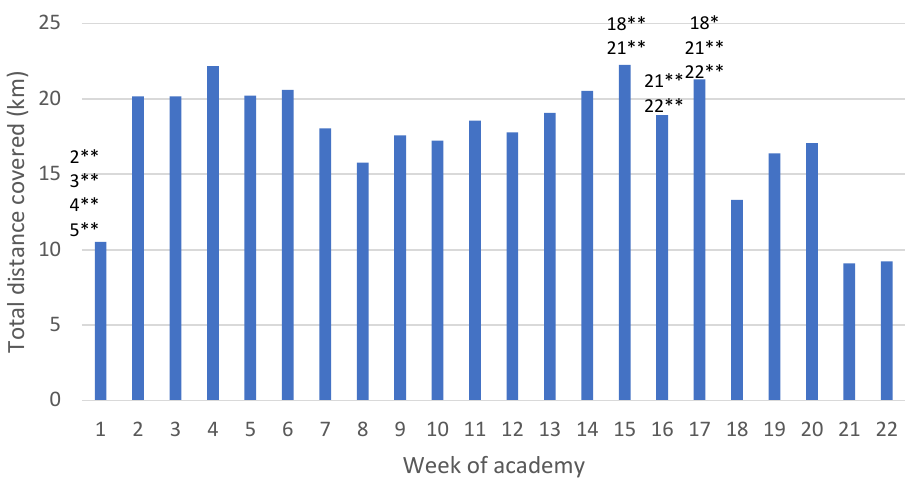
Figure 2. Average total distance covered per week across seven academy classes. Key: Numbers represent the weeks that are significantly different in total distance covered. For example, Week 16 has significantly greater distance covered than Weeks 21 and 22. *: p -value < 0.05; ** p -value < 0.01. Between Weeks 7 and 14, the distances covered plateaued, remaining between ap- proximately 15 and 20 km per week. At Week 17, the total distance covered began to de- cline to less than 10 km during the last two weeks. This decrease was also reflected in the linear mixed effect model, with significant differences between Week 15 and Weeks 18 ( − 8.96 km; p -value = <0.01) and 21 ( − 13.16 km; p -value = <0.01); Week 16 and Weeks 21 ( − 9.82 km; p -value = <0.01) and 22 ( − 9.69 km; p -value = <0.01); and Week 17 and Weeks 18 ( − 7.99 km; p -value = 0.049), 21 ( − 12.19 km; p -value = <0.01), and 22 ( − 12.07 km; p -value = <0.01). For full results of the linear mixed effects model including p- values, please refer to